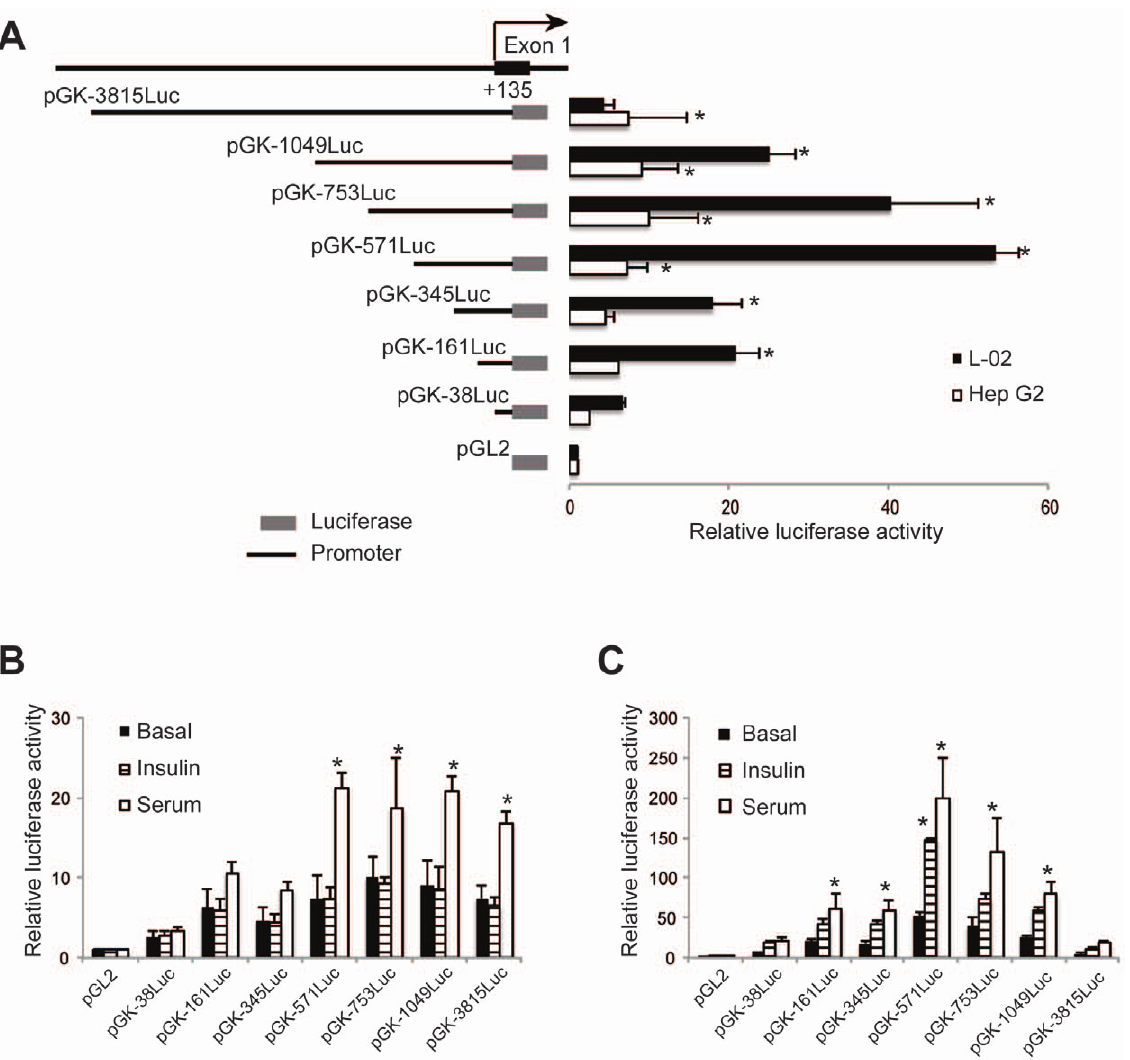
Figure 3. Transcriptional activity of deletions of the human glucokinase 5 9 flanking sequence. A. Schematic illustrations of the human glucokinase promoter deletion constructs used to test promoter activity are shown on the left. See Fig. S1 for the locations of genomic fragments within the gene. Reporter gene activity in two human cell lines, HepG2 and L-02 is shown on the right. Asterisk (*) indicates reporter gene activity that is significantly greater than that from pGL2 basic. Data are the Mean 6 SD of three independent experiments. B and C. Responsiveness of the human glucokinase promoter constructs to insulin and fetal calf serum (serum) in HepG2 (B) and L-02 (C) cells. Basal refers to culture without insulin or serum. Constructs from part A were incubated in the presence of absence of 100 nM insulin or 10% fetal calf serum for 20 hours. Data are the Mean 6 SD of three independent experiments. Asterisk (*) indicates conditions that have significantly greater activity than the basal level for that construct (P , 0.05).